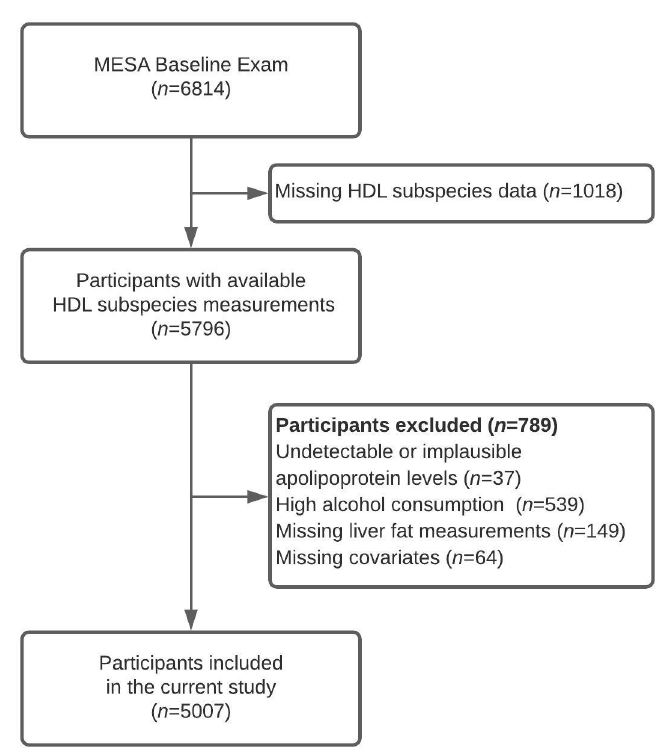
Figure 1. Flowchart presenting study sample selection process. MESA—Multi-Ethnic Study of Atherosclerosis.